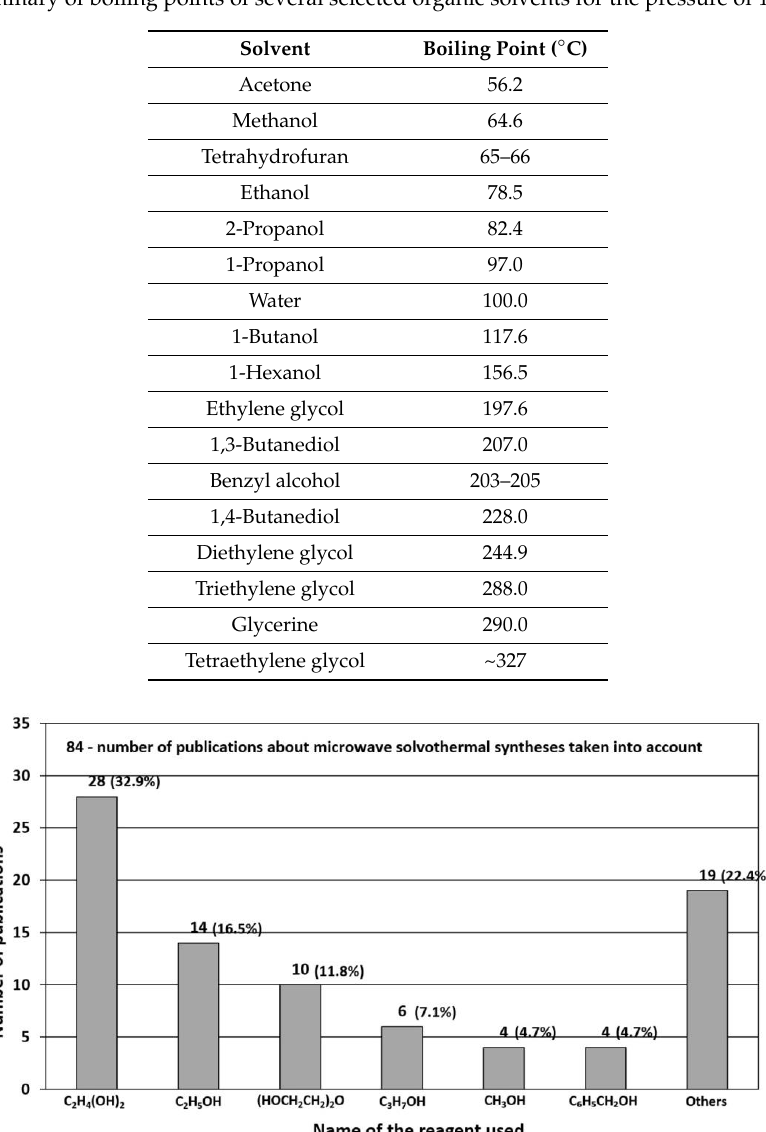
Table 9. Summary of boiling points of several selected organic solvents for the pressure of 1013.25 hPa.